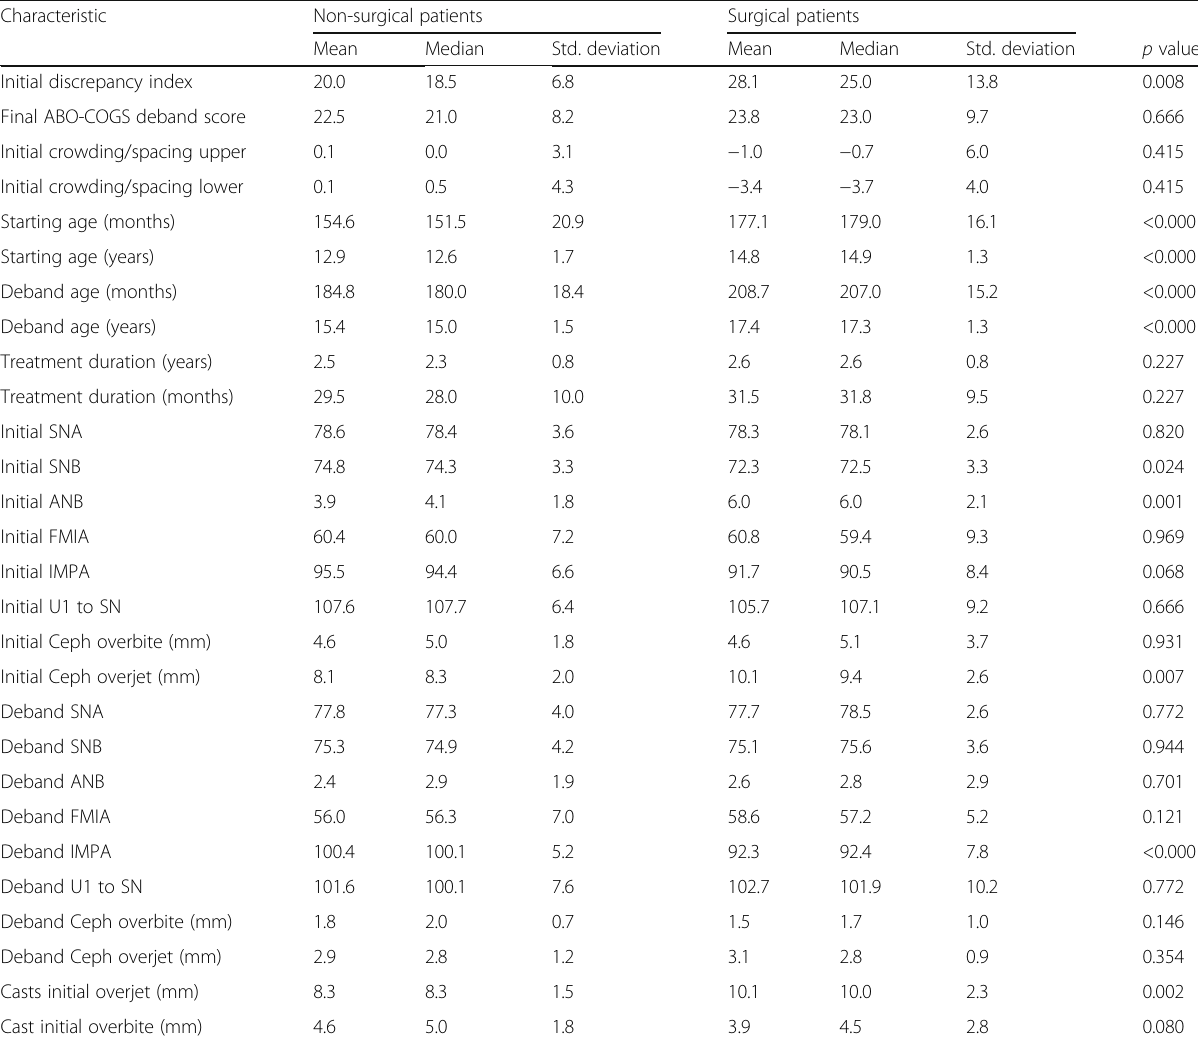
Table 1 Comparison of descriptives between treatment groups